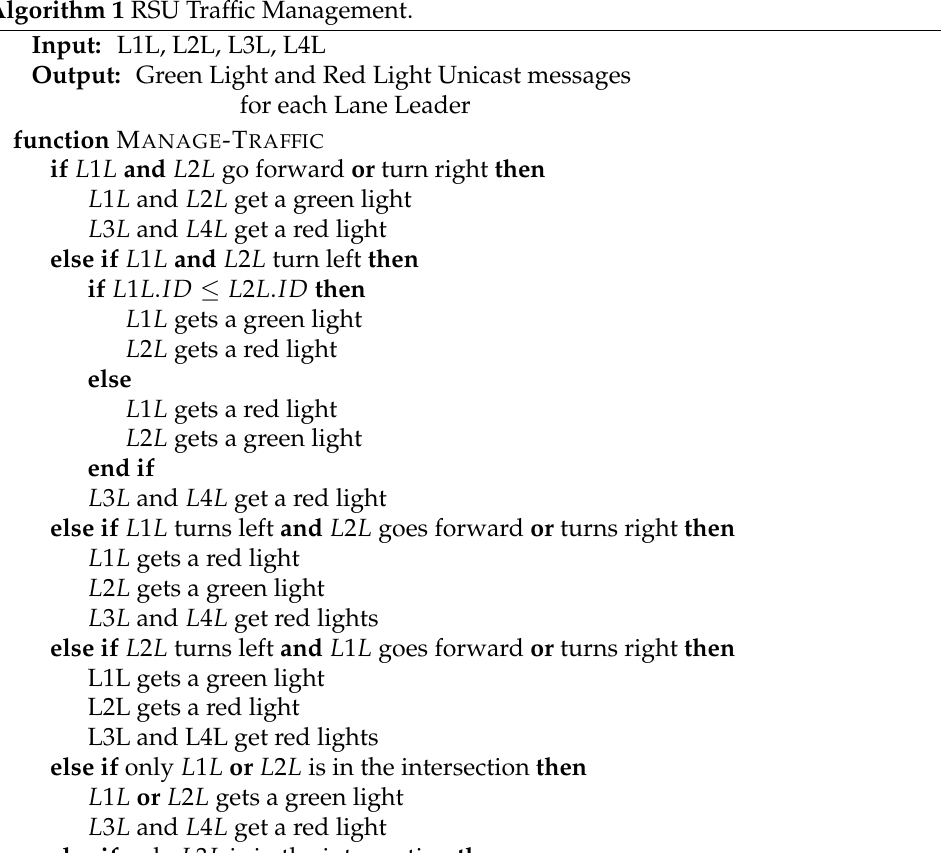
Algorithm 1 RSU Traffic